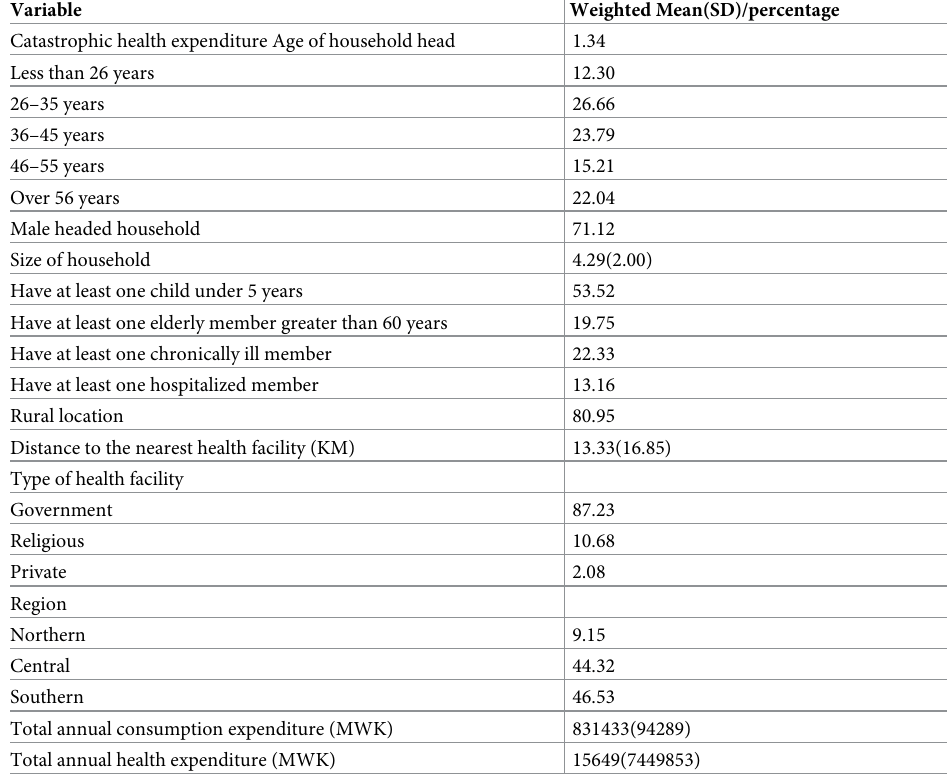
Table 1. Summary statistics of sampled households (n = 12447).